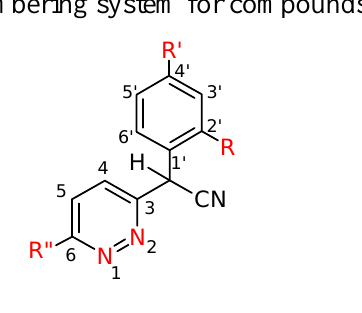
Figure 2 . Numbering system for compounds